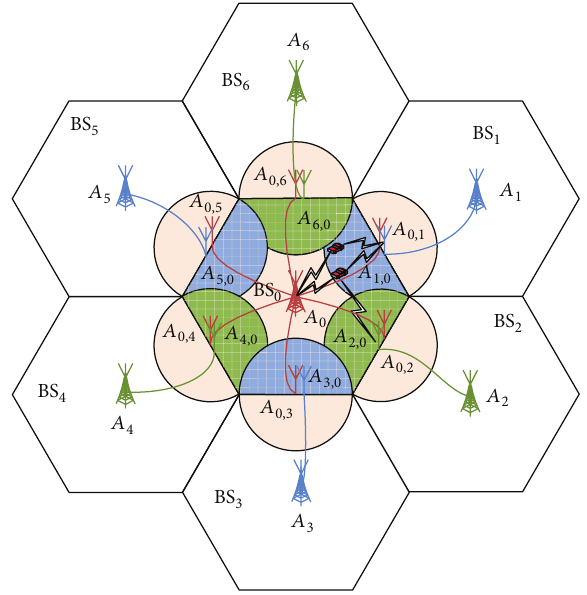
Figure 1: The typical cellular deployment scenario with